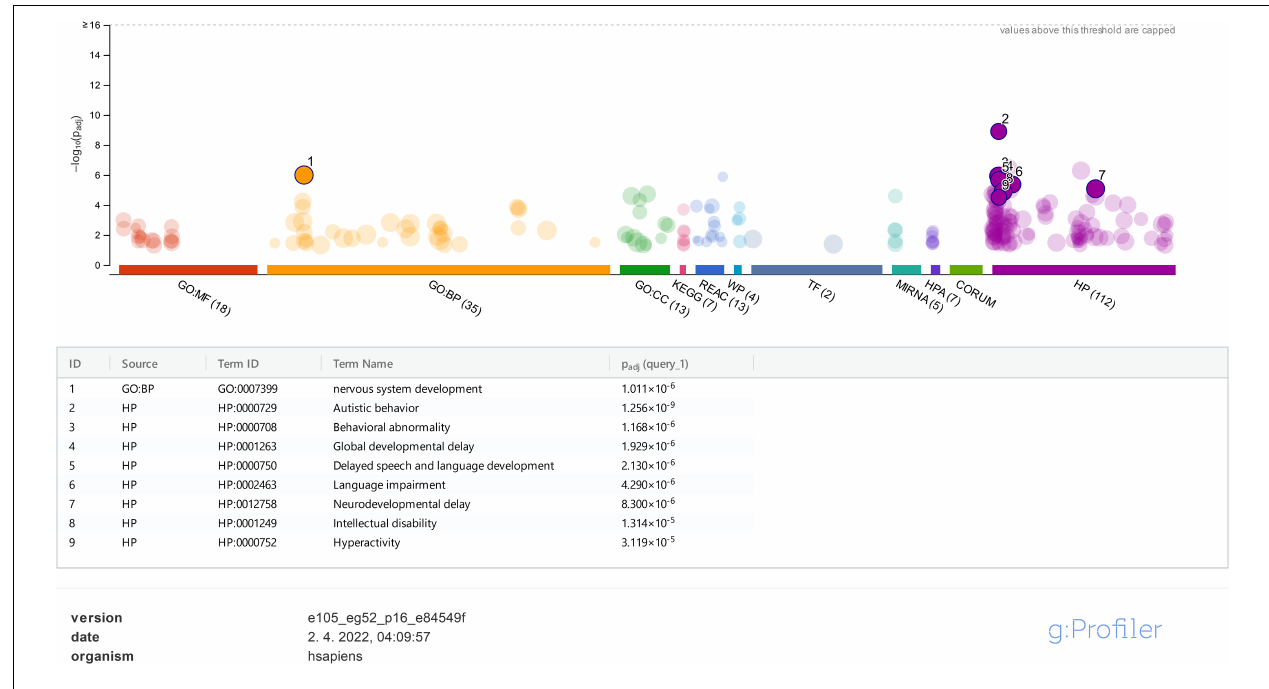
FIGURE 4 | g:Profiler analysis for the studied genes based on GO is presented for molecular function (MF), biological process (BP), cellular component (CC), biological pathways (KEGG, Reactome, and WikiPathways), regulatory motifs in DNA (TF and MIRNA), protein databases (HPA and CORUM), and Human Phenotype Ontology (HP). Only data for BP and HP were analyzed and represented in the